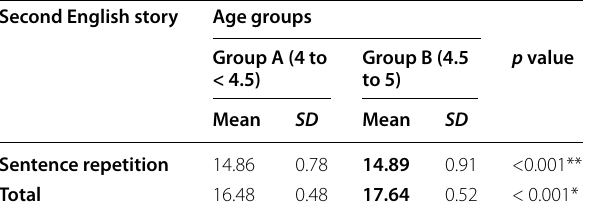
Table 8 Comparison between the scores of Arabic and English Narration Test in the first story (the doll) in age group A Group A (4 to < 4.5)